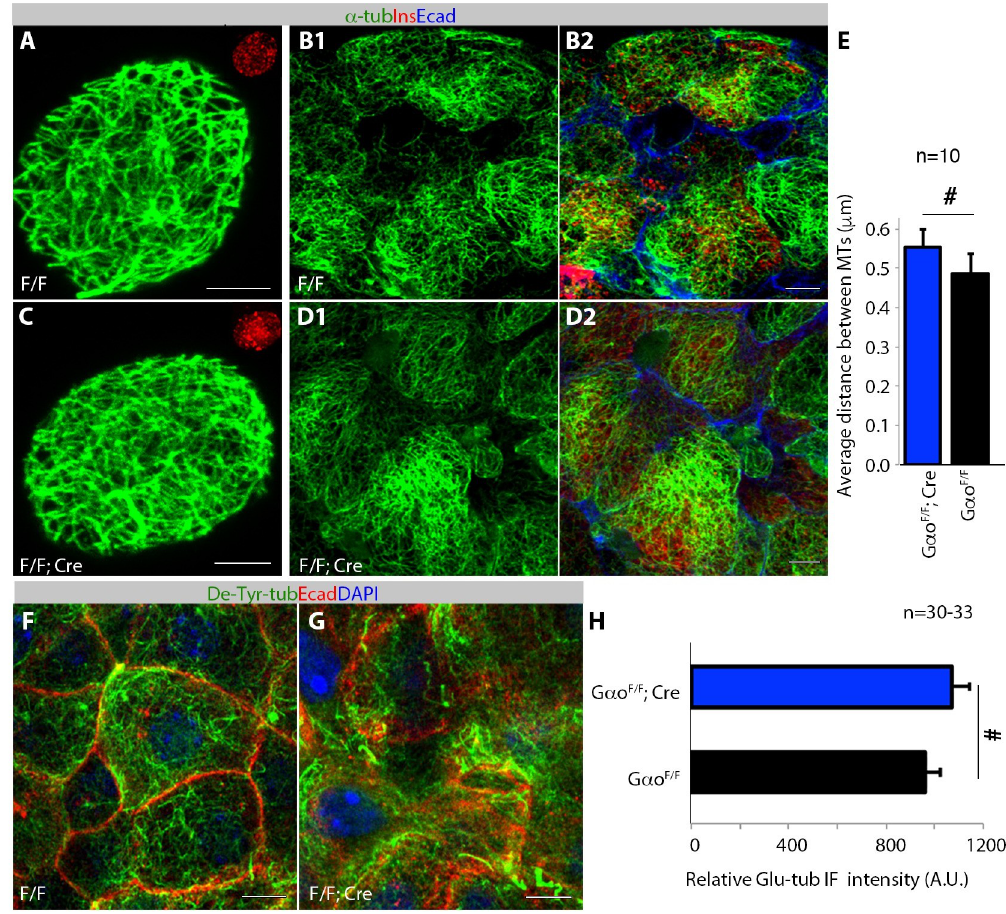
Fig 5. Inactivating G α o does not alter MT stability and density in β cells. (A-E) The MT density in control and G α o F/F ; Pdx1 Cre β cells, stained for tubulin (green), insulin (red), and E-cadherin (blue). Single cells attacehd to coverslips (A, C) or intact islets (B, D) were used. Insets in (A), (C), insulin staining to identify β -cells. Note that in (B, D), a single α -tubulin and a composite channel are presetented. The quantification data in E is MT density in single β cells, which measured the average distances between microtubules at any raodom direction. (F-H) The density of Glu-tubulin in control and G α o F/F ; Pdx1 Cre β cells. Glu-tubulin (green), E-Cadherin (red), and DAPI (blue) signals via immunofluorescence are shown. Presented data in (E) and (H) are (mean + SEM). #: p > 0.2, results from two-tail type II t-test. Scale bars, 5 μ m. Please refer to S1 Table for original numbers used in